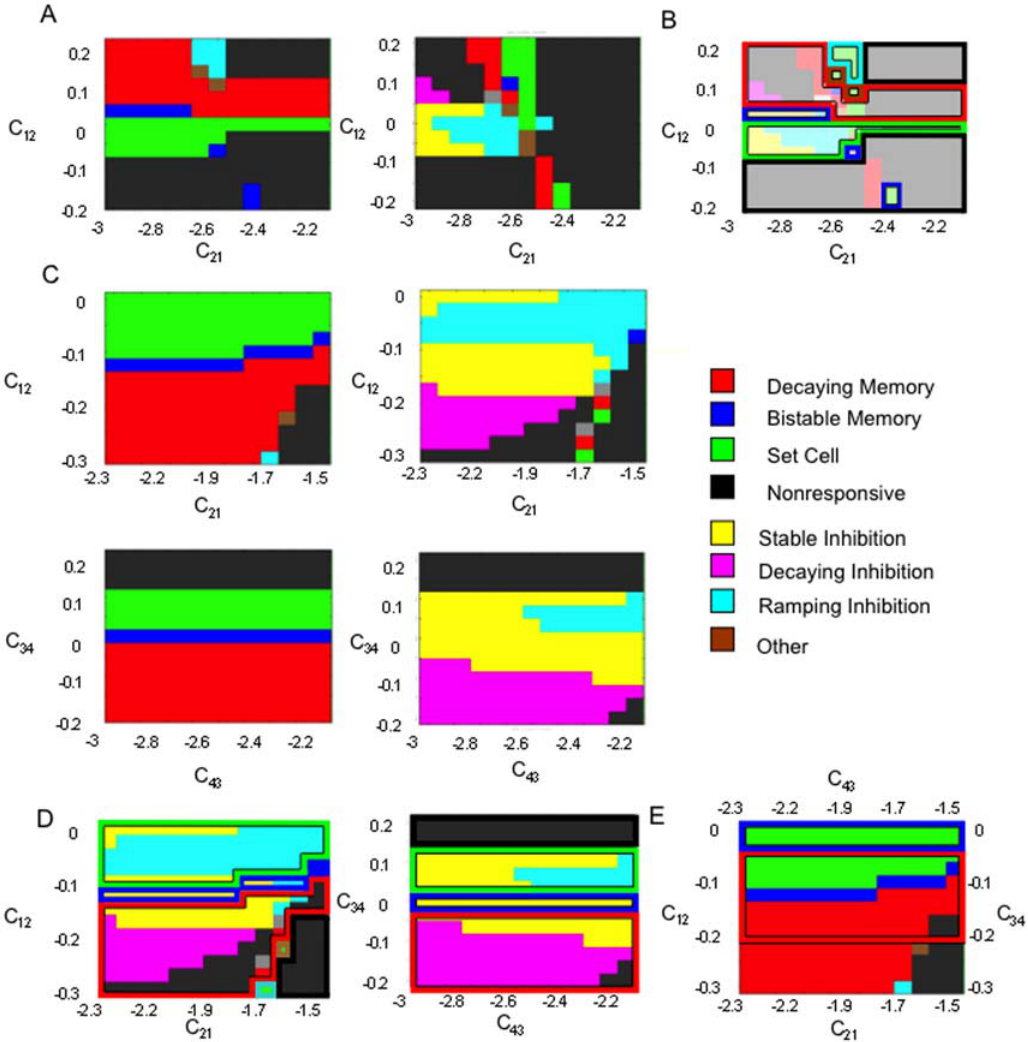
Figure 6. Phase diagrams of the patterns exhibited by the 2- and 4-population firing rate models. The phase diagrams were created using the same procedure carried out for the generation of the phase diagram of the single-population model. A) Phase diagrams of the activities of the 2-population model as a function of the inter-population connectivity. Left : Phase diagram of population 1. Right : Phase diagram of population 2. The self connectivity of population 2 (0.9) is slightly less than population 1 (1.0) so that the phase diagrams of the two populations are not identical. Excitatory-Inhibitory (E-I) and Inhibitory-Inhibitory (I-I) connectivity architectures between the populations are examined. The pattern category ‘‘other’’ corresponds to decaying or ramping cell behavior in which the average firing rate of one period of the delay–D1 or D2–is significantly less than the baseline (i.e. at least 0.5 Hz less than the firing rate during the period B), while the other is significantly greater (i.e. at least 0.5 Hz greater than the firing rate during the period B). Note that all of the pattern types (excitatory, inhibitory and nonresponsive) are obtained over a wide range of the parameters. B) The overlapping simultaneously occurring patterns in the 2 population network across the range of inter-population connectivity values. The figure shows the 1 and 2 populations’ (left and right phase diagrams of panel A to the left) phase diagrams superimposed on each other. The 1-population states are shown as solid, and the corresponding 2-population states are shown in outline. Discrete regions of the overlapping phase diagrams reveal simultaneously occurring network behaviors observed in cortex during working memory. Included is simultaneous occurrence of decaying memory behavior in both populations (red-red overlap), and stable memory behavior in one population and ramping cell behavior in the other (blue-green overlap). Also common network behaviors observed are the simultaneous occurrence of the excitatory patterns in one population and the nonresponsive pattern in the other. Inhibitory patterns tend to occur in one population primarily with ramping cell behavior in the other. C) Phase diagrams of the activities of the 4-population model as a function of the inter-population connectivity. Upper left : Phase diagram of population 1. Upper right : Phase diagram of population 2. Lower Right : Phase diagram of population 3. Lower Right : Phase diagram of population 4. All the pattern types are exhibited by the network. However, the populations partition themselves such that they exhibit almost exclusively either excitatory or inhibitory memory patterns across the values of interpopulation connectivity. D) Simultaneously occurring patterns in populations 1 and 2, and in populations 3 and 4. E) Simultaneously occurring patterns in populations 1 and 3. The figure shows 1 and 3 (excitatory) populations’ phase diagrams superimposed on each other. Over a significant range of the parameters, memory cell behavior and ramping cell behavior co-occur (red and green overlap). The existence of such simultaneous population behavior has been indicated in prefrontal cortex. Memory cell behavior is also seen to simultaneously occur in multiple populations across a wide continuous range of the parameter space (red-red and red- blue overlap).